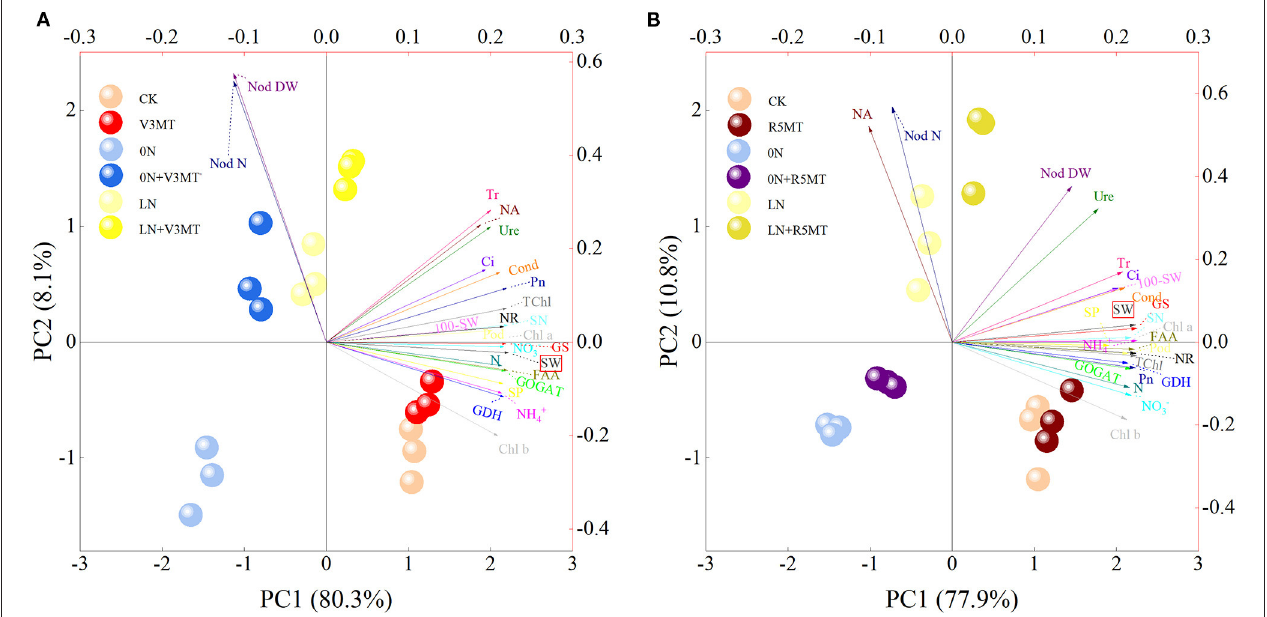
FIGURE 13 | Principal components analysis (PCA) biplot showing the differences among treatments after melatonin spraying at V3 (A) or R5 (B) stage and the relationship among the related indicators that describe them. The relevant indicators are shown by arrows, while the different treatments are indicated as points. NR, Nitrate reductase; GS, glutamine synthetase; GOGAT, glutamate synthase; GDH, glutamate dehydrogenase; NO − 3 , nitrate; NH + 4 , ammonium; SP, soluble protein; FAA, free amino acid; Nod N, nodules number; Nod DW, nodules dry weight; NA, nitrogenase activity; Ure, ureide; N, nitrogen; Pn, net photosynthetic rate; Cond, stomatal conductance; Ci, intercellular carbon dioxide concentration; Tr, transpiration rate; Chl a, chlorophyll a; Chl b, chlorophyll b; TChl, total chlorophyll; Pod, pod number; GN, grains number; 100-SW, 100-seed weight; SW, seed weight. The abbreviated meaning of each treatment is the same as in Figure 3